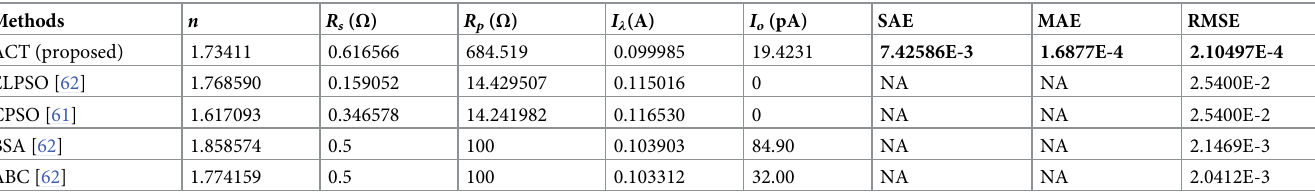
Table 4. Comparison of different parameter extraction methods with the proposed ACT tested for single-diode model of PVM 752 GaAs thin film cell. Methods